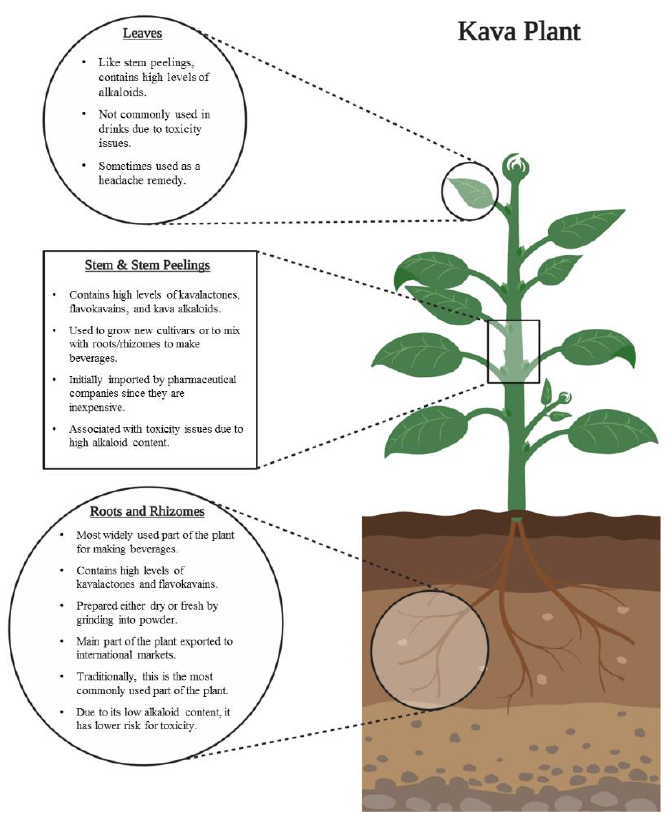
Figure 6. Different parts of kava plant and their features. Figure 6. Di ff erent parts of kava plant and their